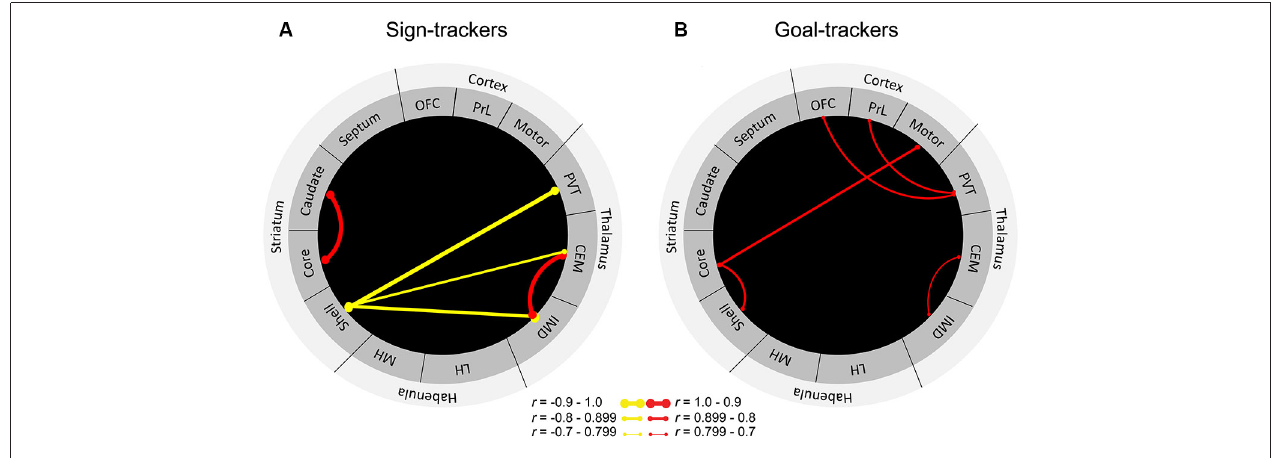
stronger the correlation. Abbreviations: OFC, orbitofrontal cortex; PrL, prelimbic cortex, PVT, paraventricular nucleus of the thalamus; CEM, centromedial nucleus of the thalamus; IMD, intermediodorsal nucleus of the thalamus; LH, lateral habenula; MH, medial habenula. Adapted from Flagel et al.